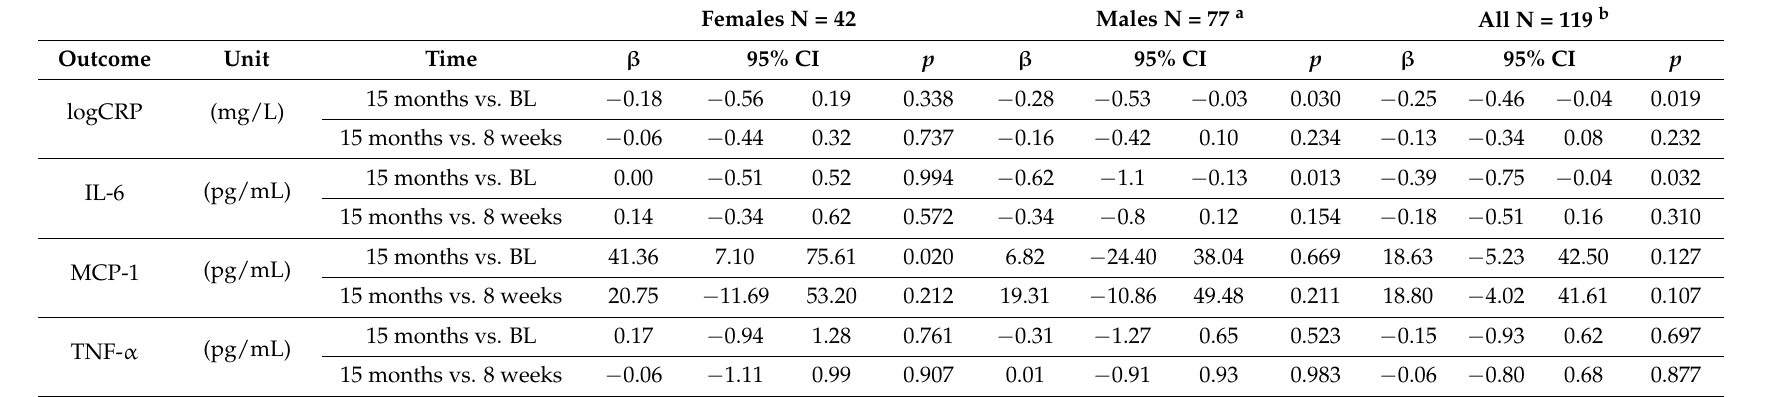
Table 4. CRP, IL-6, MCP-1 and TNF- α .